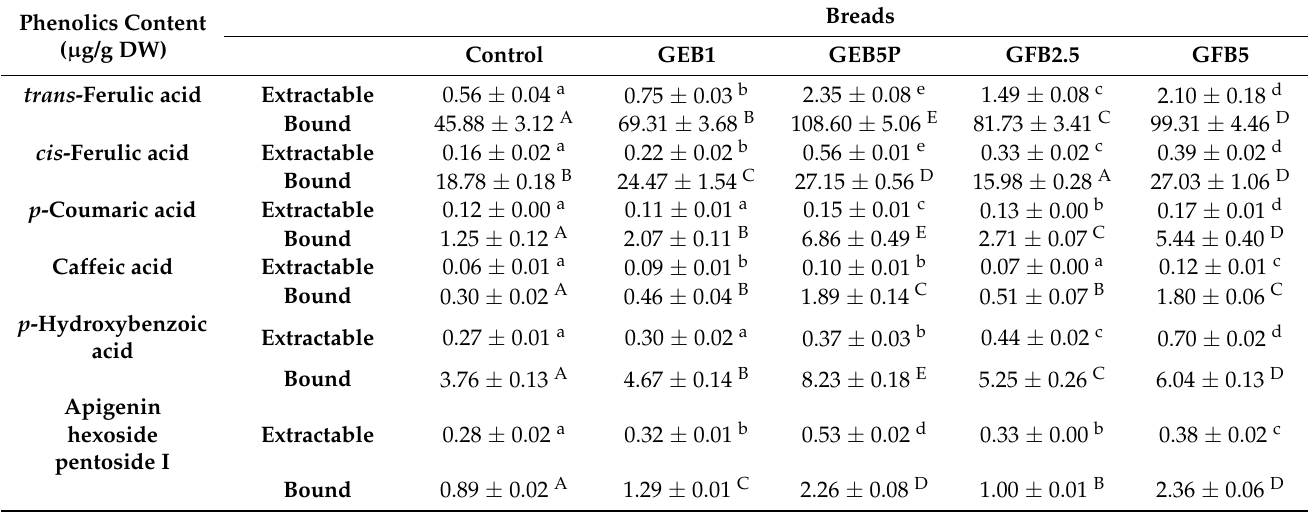
Table 4. Contents of individual phenolic compounds in the extractable and bound fractions of control and bioprocessed